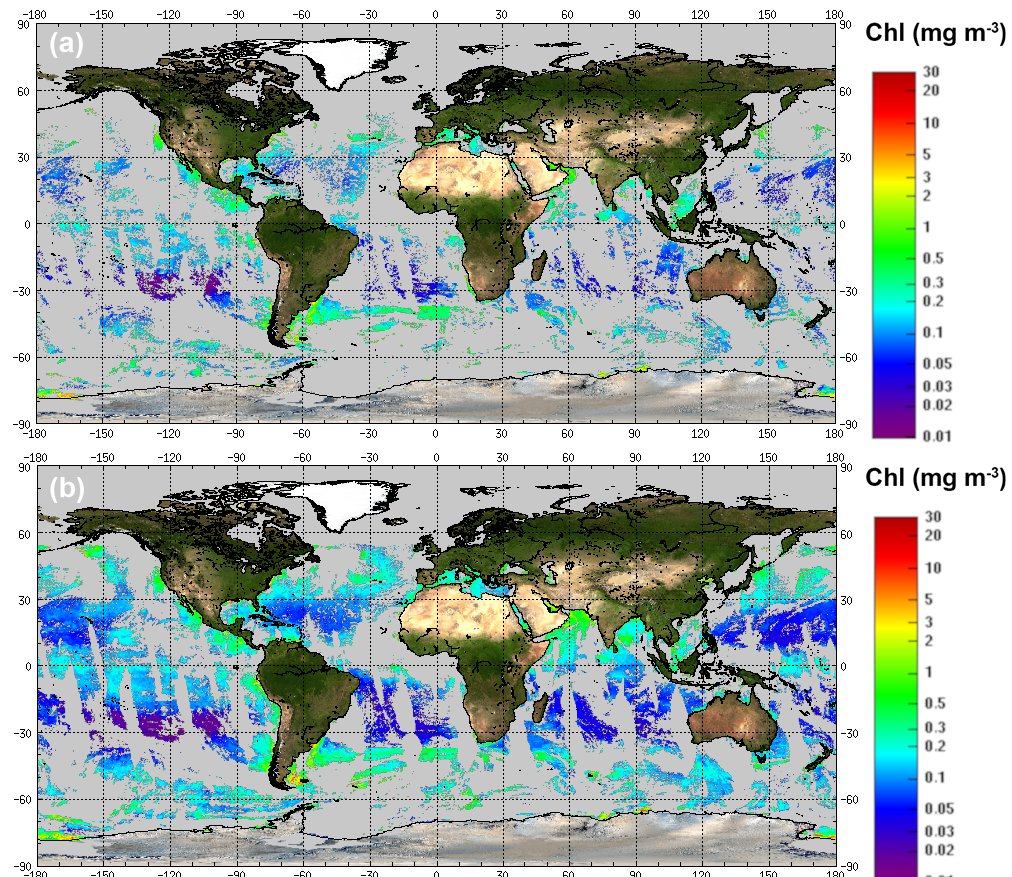
Figure 10. The chlorophyll a concentration (1 January 2012) for (a) the OC-CCI level 3 product and (b) the GlobColour product. The two initiatives used MODIS Aqua, MERIS and VIIRS-SNPP at this time.